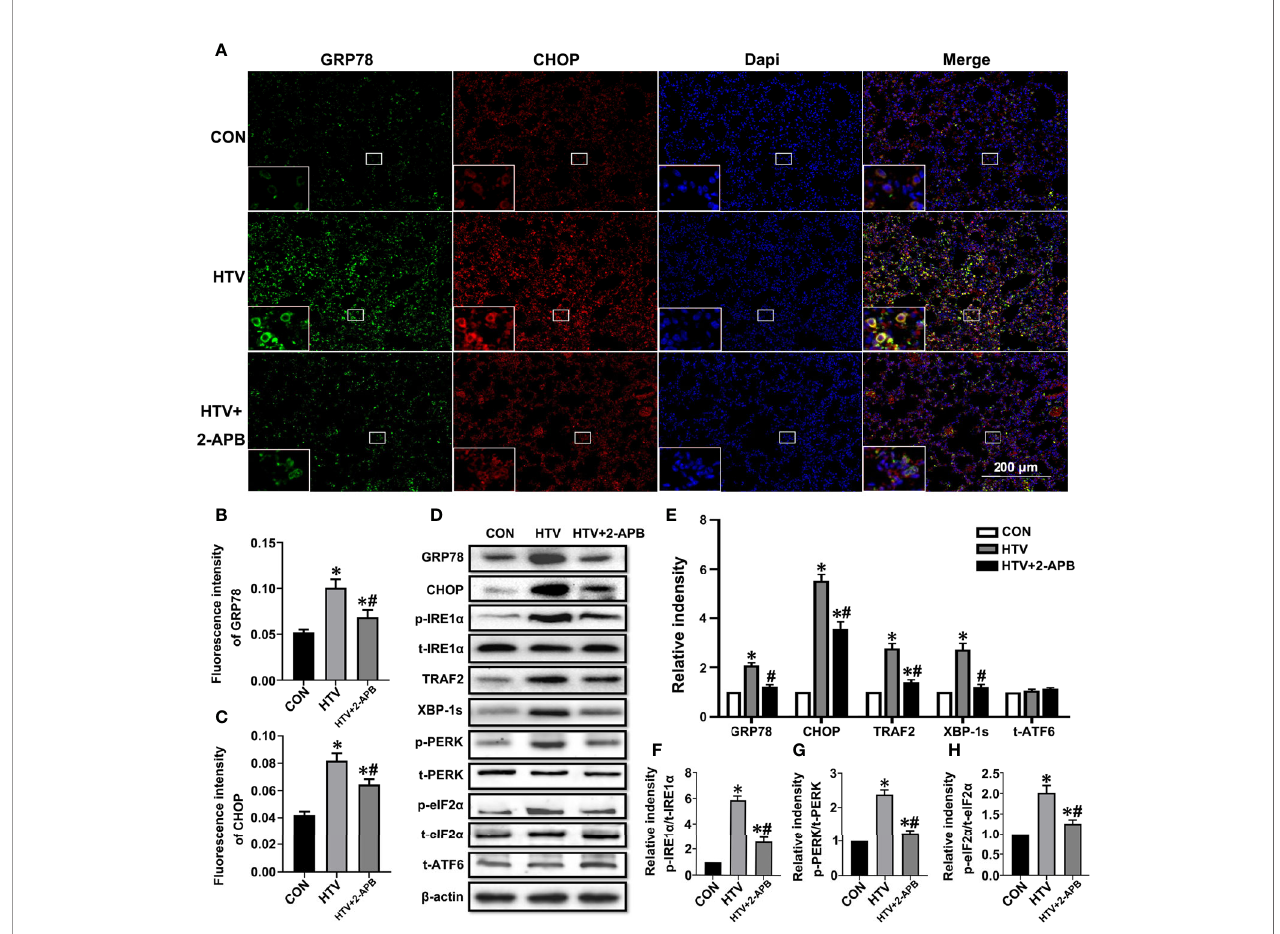
FIGURE 5 | 2-APB inhibits ER stress in HTV-treated mice. (A) Immuno fl uorescence photomicrographs of GRP78 (green) and CHOP (red) in lung tissues of group CON, HTV, and HTV+2-APB mice. Dapi (blue) was used to stain the nuclei. Scale bar: 200 m m. An inset picture was employed to show the indicated area at 4X magni fi cation. (B, C) Graphic presentations of fl uorescence mean densities of GRP78 and CHOP. (D) Levels of GRP78, CHOP, p-IRE1 a , t-IRE1 a , TRAF2, XBP-1s, p-PERK, t-PERK, p-eIF2 a , t-eIF2 a , t-ATF6, b -actin proteins by Western blot. (E) Relative protein expression of GRP78, CHOP, TRAF2, XBP-1s and t-ATF6 relative to b -actin. (F) The relative ratio of p-IRE1 a protein was presented to t-IRE1 a . (G) The relative ratio of p-PERK protein was presented to t-PERK. (H) The relative ratio of p-eIF2 a protein was presented to t-eIF2 a . Data are expressed as means ± SD (n = 6 per group). * P < 0.05 vs . CON group. # P < 0.05 vs . HTV